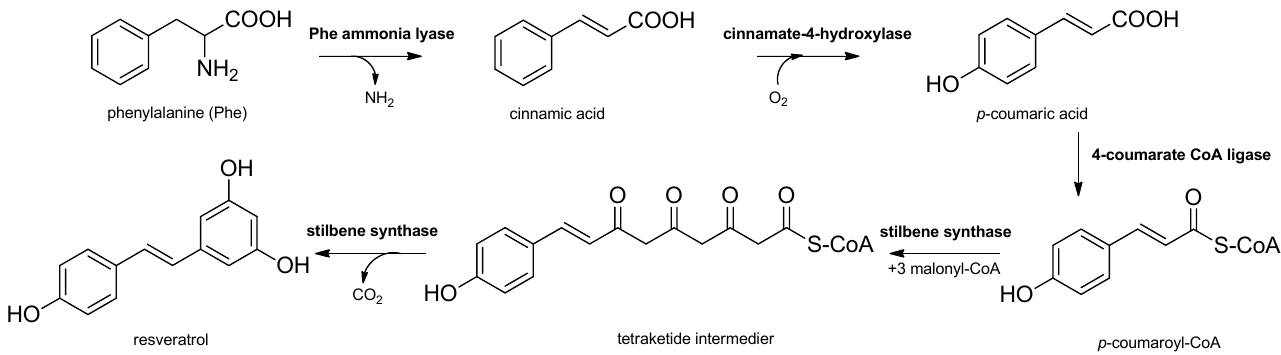
Figure 1. Biosynthesis of stilbenes .